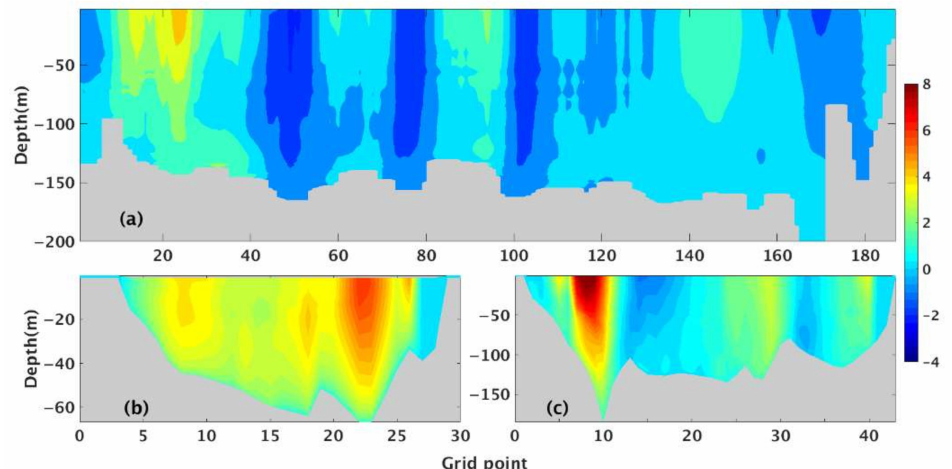
Figure 4. ( a ) Vertical distribution of the annual-mean heat transport across the SBS. ( b , c ) are identical plots for the TAS and TUS, respectively. The locations of these three sections are provided in Figure